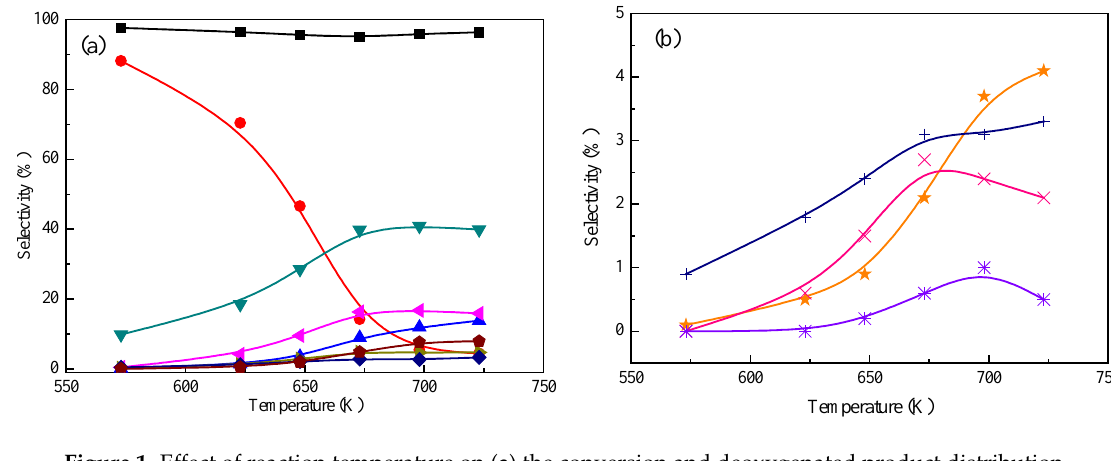
Figure 1. Effect of reaction temperature on ( a ) the conversion and deoxygenated product distribution and ( b ) oxygenated product distribution from m -cresol HDO. : m- cresol conversion,